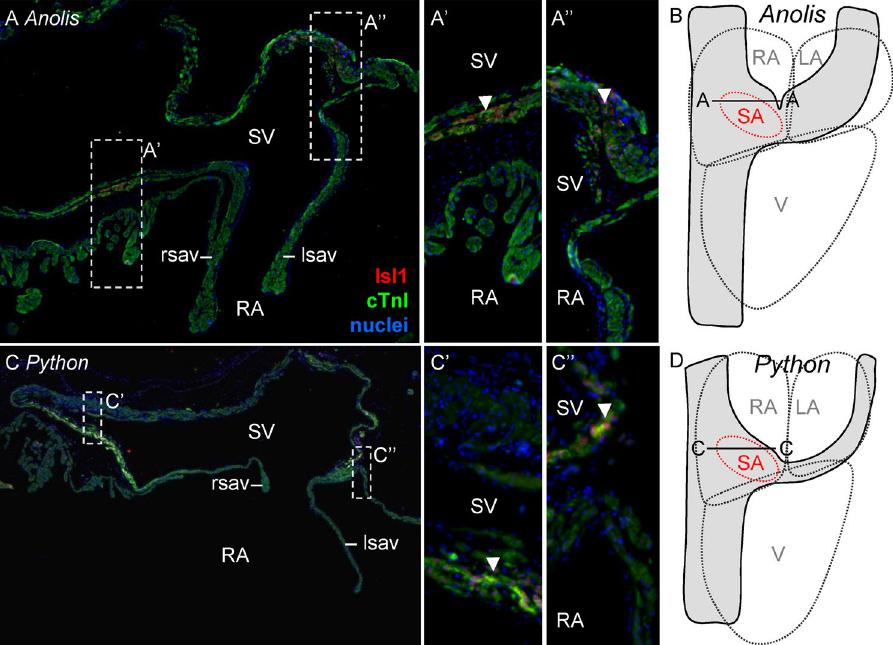
Figure 1. Identification of the putative dominant pacemaker by Isl1 detection. ( A ) Histological section of sinuatrial junction of the adult Anolis equestrie , showing the left and right leaflet of the sinuatrial valve (lsav and rsav, respectively). Isl1 in myocardial nuclei is expressed (arrow heads) immediately upstream of the sinuatrial valve in a ring-like domain. ( B ) This cartoon indicates the sectioning plane (A-A) relative to the sinuatrial junction (SA) and whole heart. The outline of the sinus venosus is indicated in grey. ( C , D ) Isl1 in the adult Python regius is expressed as in Anolis . LA, left atrium; RA, right atrium; SV, sinus venosus; V,